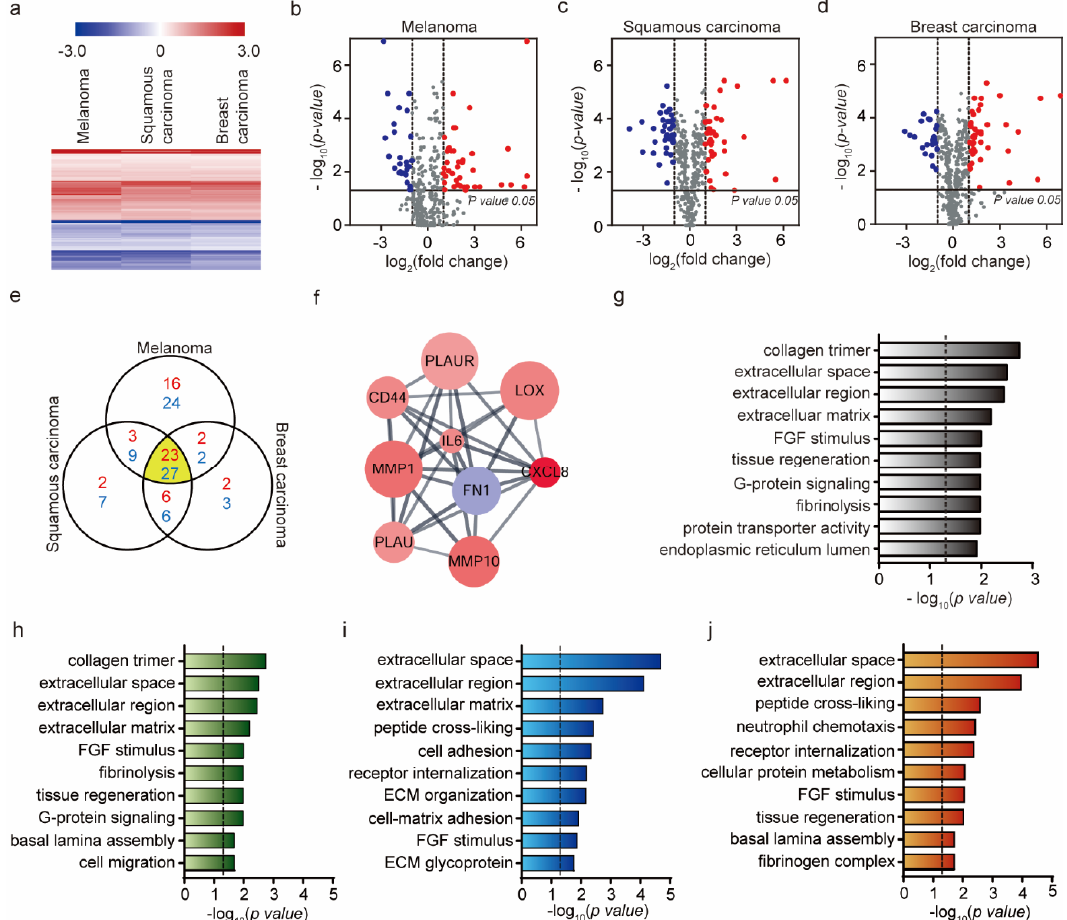
Figure 2. Identification of differentially expressed genes from eCAFs and their biological functions. ( a ) Hierarchical clustering of expression profiles of differentially expressed mRNAs among three eCAFs (the eCAFs were produced by the exosomes extracted from B16BL6, A431 and MDA-MB-231 cells) ( p -value < 0.05). Red color indicates high relative expression and blue indicates low relative expression. ( b – d ) Volcano plot showing gene expression differences among the three eCAFs. Red, DE genes with log 2 (fold change) > 1; blue, DE genes with log 2 (fold change) < − 1. ( e ) Venn diagram showing differentially expressed overlapping gene numbers for three eCAFs. The number of overlapping regions shows the largest number of differentially expressed genes. Red represents log 2 (fold change) > 1 and blue represents log 2 (fold change) < − 1. ( f ) Top module of the protein–protein interaction (PPI) network for densely connected nodes. Red, DE genes with log 2 (fold change) > 1; blue, DE genes with log 2 (fold change) < − 1. Larger node size is associated with a more significant p -value. ( g ) Gene ontology (GO) term enrichment analysis of common mRNA expression in three eCAFs ( p -value < 0.05, | log 2 ( fold change) | > 1). ( h – j ) Gene ontology (GO) term enrichment analysis of expressed mRNA; B16BL6, A431, MDA-MB-231 cells ( p- value < 0.05, | log 2 (fold change) | > 1). The dashed line signifies p -value of 0.05.